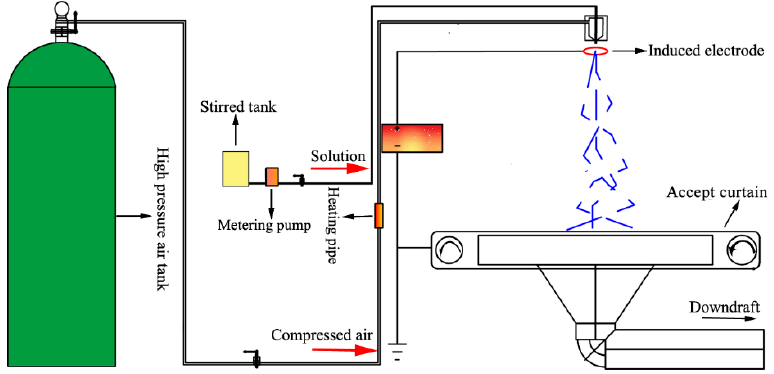
Figure 1. Schematic of the preparation of transparent air filter material by electrostatic induction- assisted solution